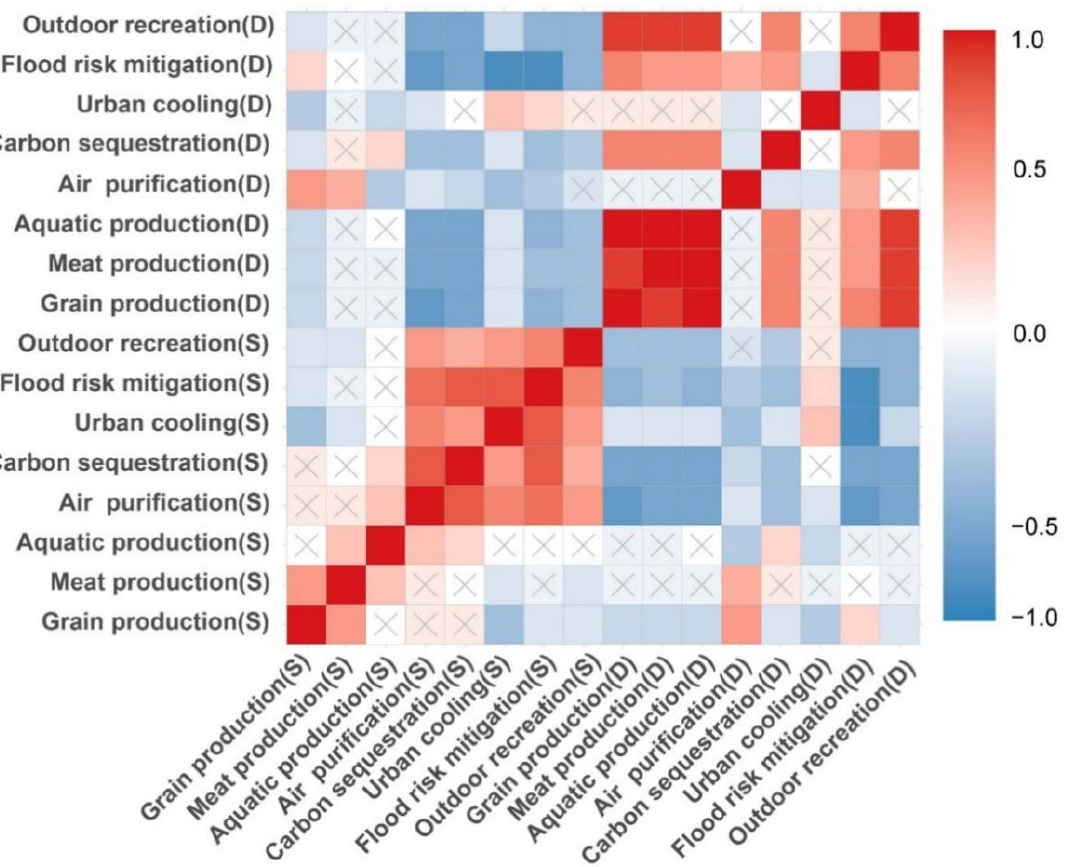
Figure 6. The Pearson correlation matrix of all the sixteen ES supply and demand indicators. The “ × ” indicates non-significant relationship ( p > 0.05).